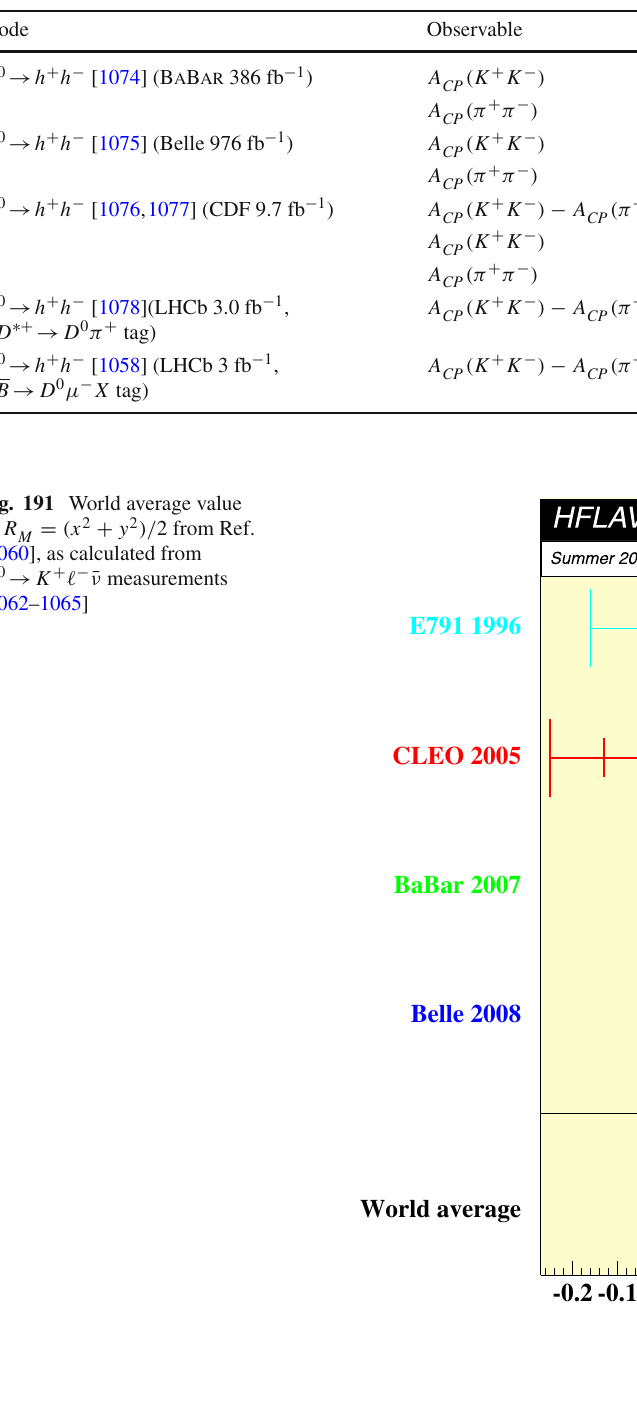
f ) + (cid:6)( ¯ D 0 → f ) ] , and (cid:5) (cid:17) t (cid:18) is the difference between the mean recon-